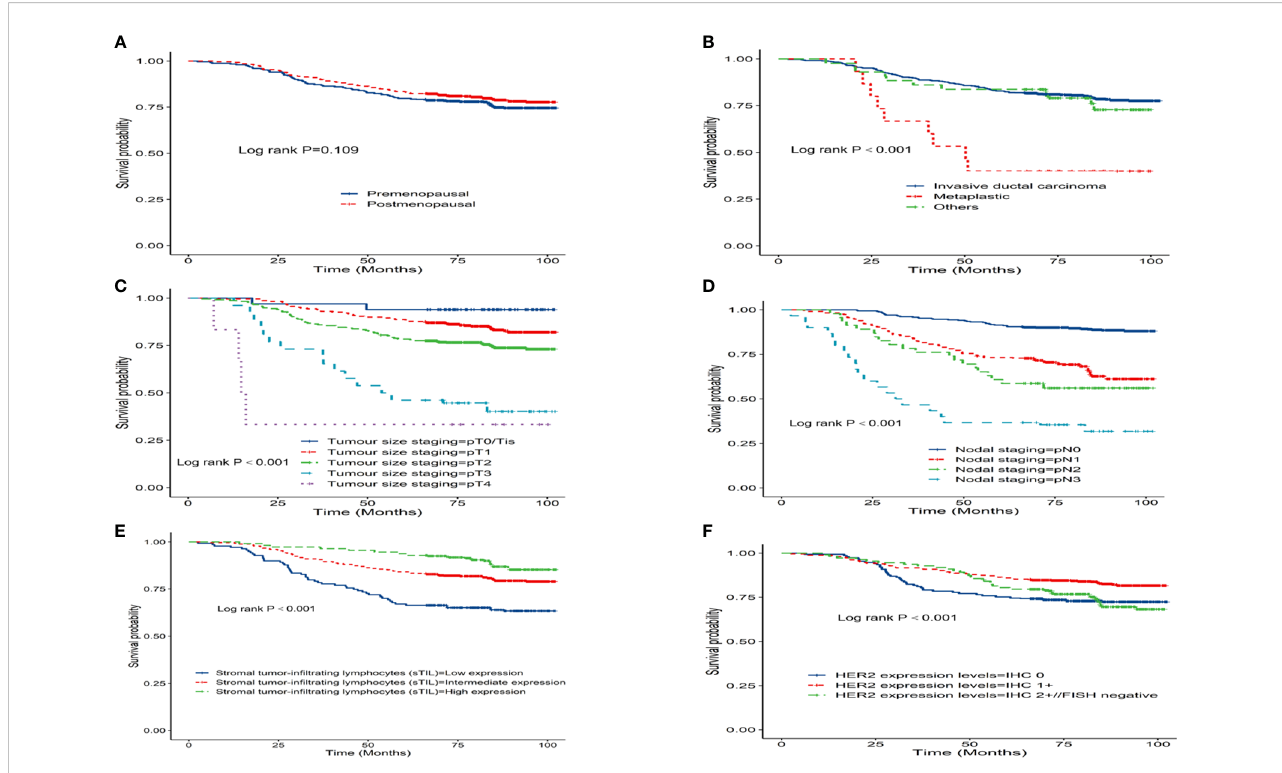
FIGURE 6 K-M overall survival analysis of all TNBC patients in six predictors for rapid relapse (A) Menopausal status at diagnosis; (B) Pathological pattern; (C) Tumour size staging; (D) Nodal staging; (E) Stromal tumor-in fi ltrating lymphocytes(sTIL); (F) Her2 expression levels).